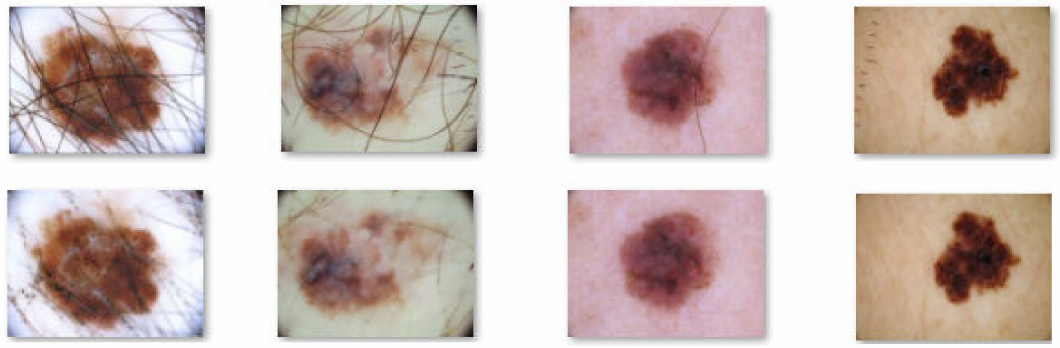
Figure 3. Results obtained after applying the DullRazor algorithm on common nevus images.